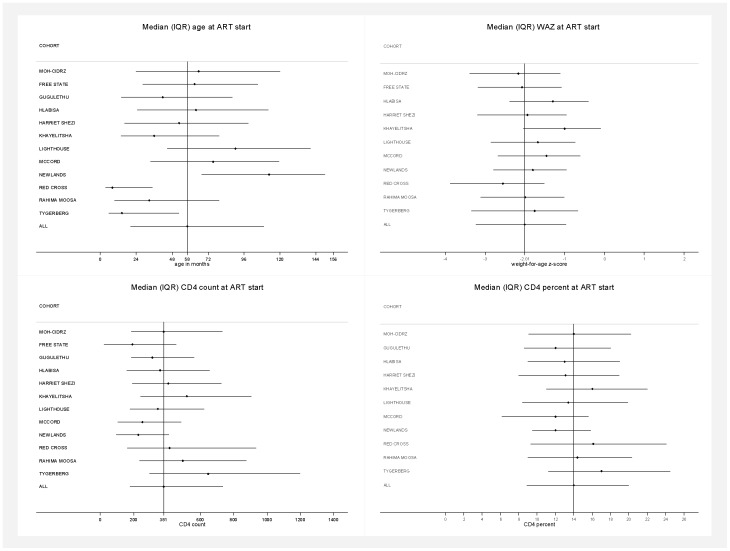
Characteristics of children at ART start in the different cohorts (median [IQR] age, weight-for-age z-score [WAZ], CD4 count and percent).